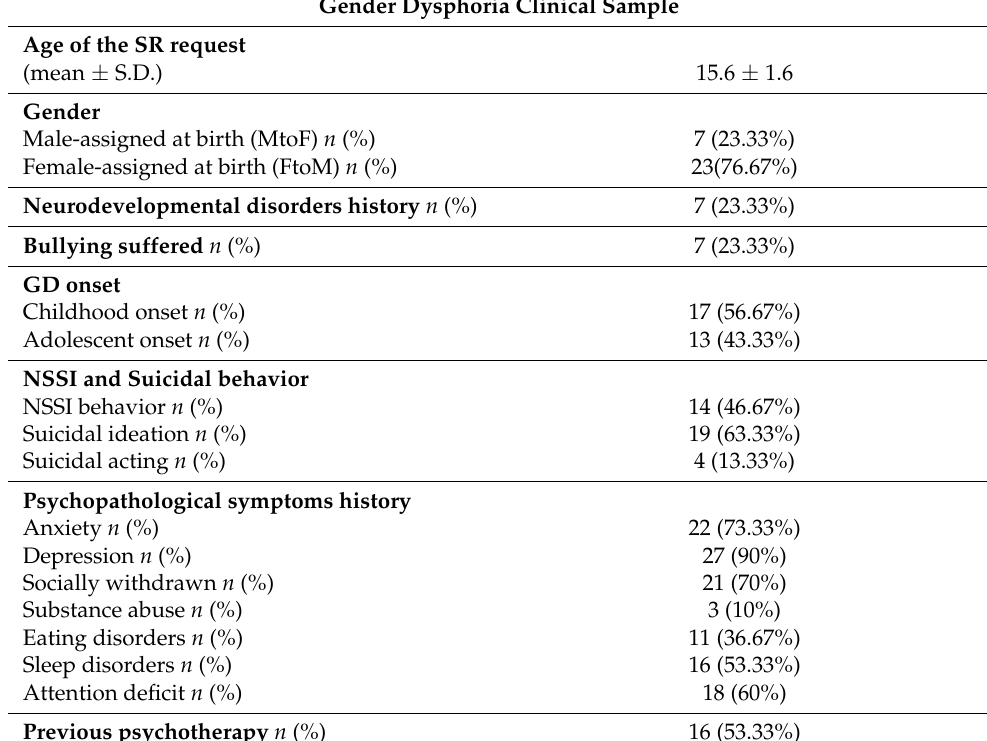
Table 1. Clinical features for GD sample.